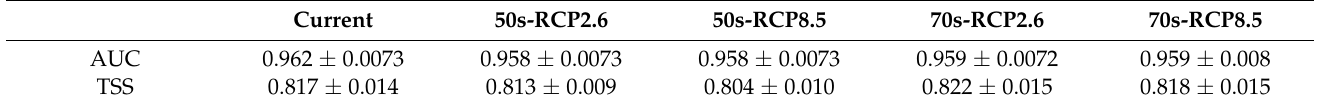
Figure 2. AUC value of Q. spinosa predicted by MaxEnt model. Table 3. Evaluate the AUC and TSS index values of the MaxENT